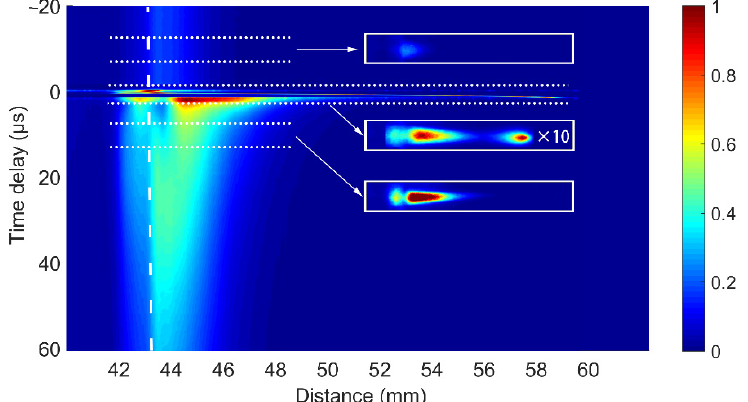
Figure 3. Time-dependent discharge image intensity of pulsed discharge, RF discharge, and plasma plume with duration of voltage pulse.